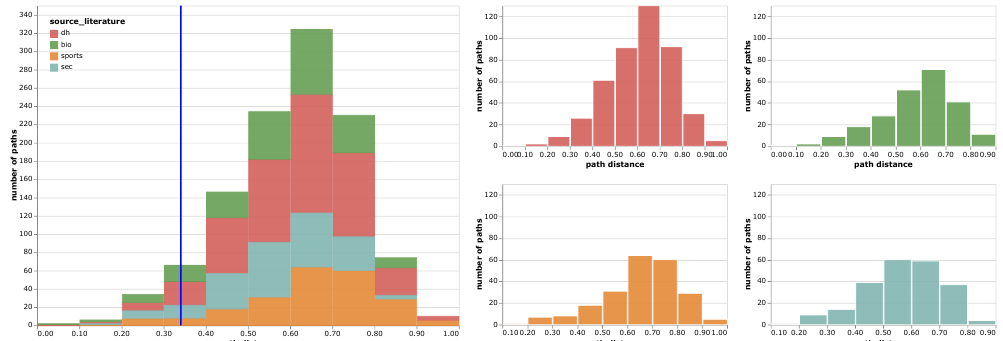
Figure 7. Left: histogram showing the distribution of distances for the found 563 shortest paths connecting domain-specific terms (notice that values on the Y-axis are doubled given that P ( a , b ) = P ( b , a ) ). The blue line shows the 5th percentile ( x = 0.3408), which was later used as a cut-off value for filtering out longer, and thus less interesting paths that were not visualized in the last stage of the study (see Figure 8). To the right, the same data are disaggregated into four charts, showing similar distance distributions for paths originating at the four collections.